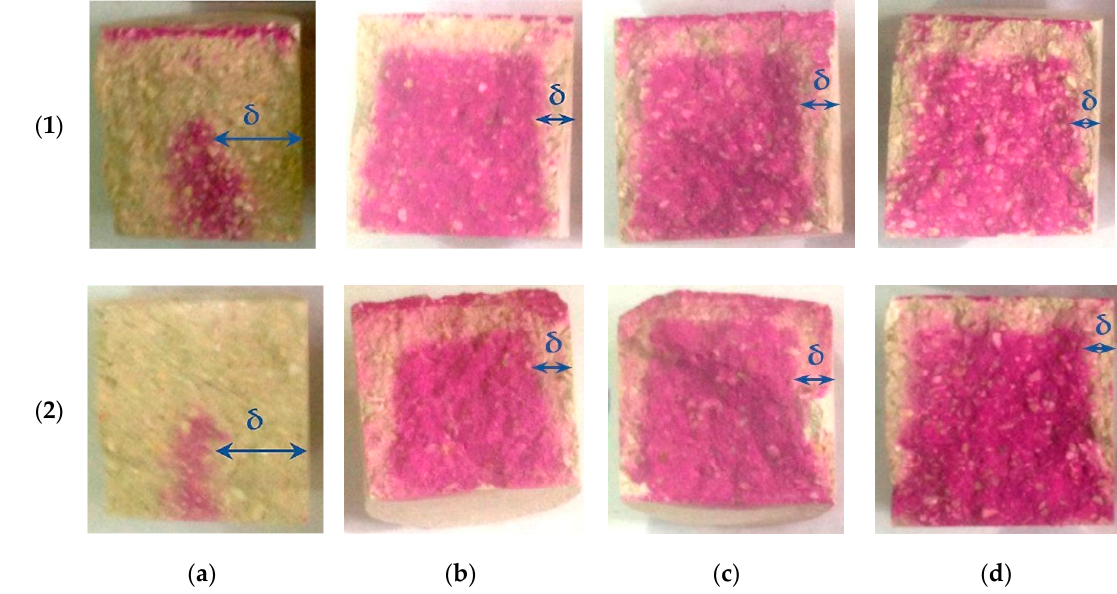
Figure 13. The thickness of the carbonated layer of testing samples obtained under dynamic ( 1 ) and static ( 2 ) modes of forced carbonation during the experiment: ( a ) point 7 of the experiment design; ( b ); point 9; ( c ) point 16; ( d ) point 25.